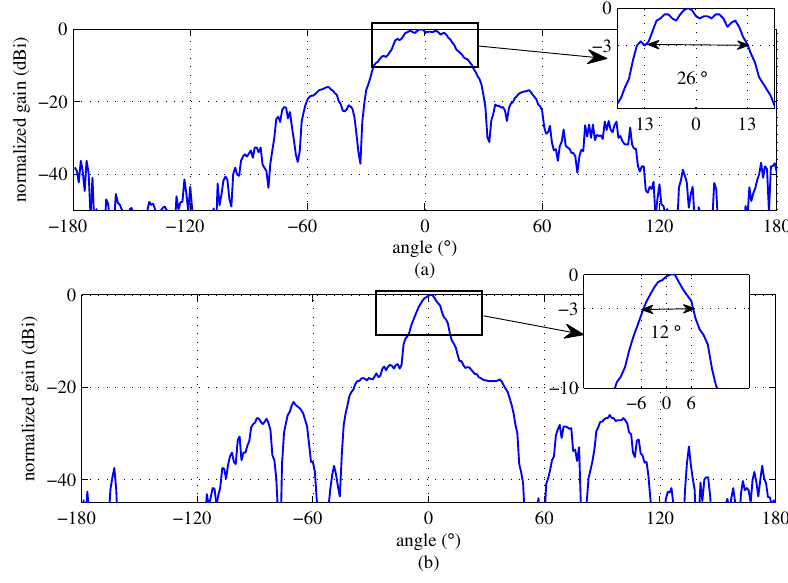
Figure 14. Radiation pattern of TX antennas; ( a ) TX antenna 1 that can cover 26 ◦ ; ( b ) TX antenna 2 that can cover 12 ◦ .